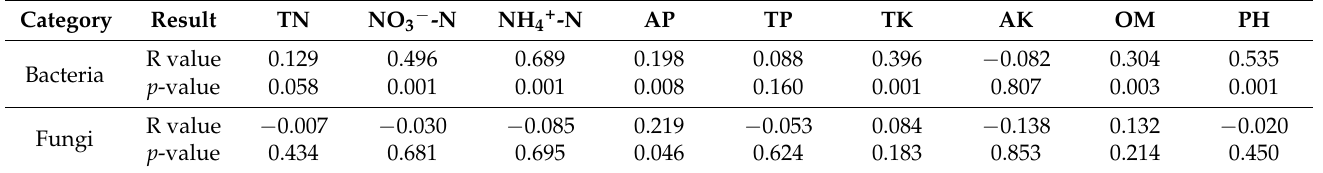
Table 2. Mantel test between soil nutrients and microorganisms.